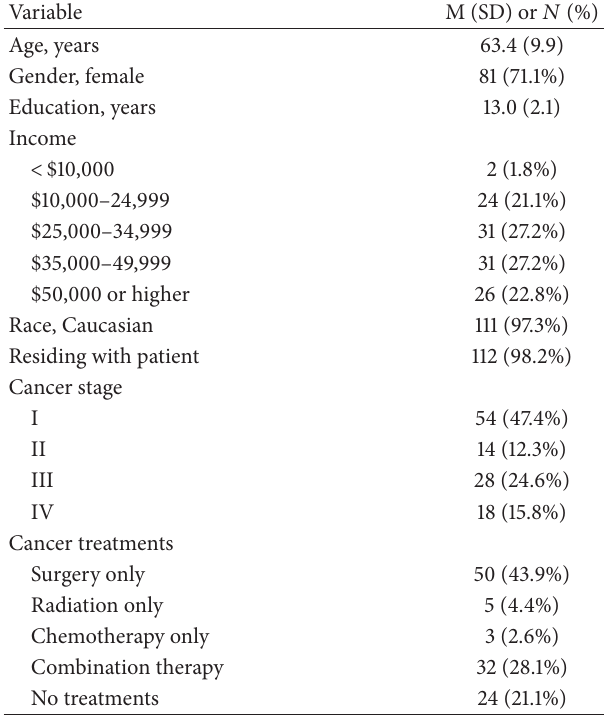
Table 1: Descriptive